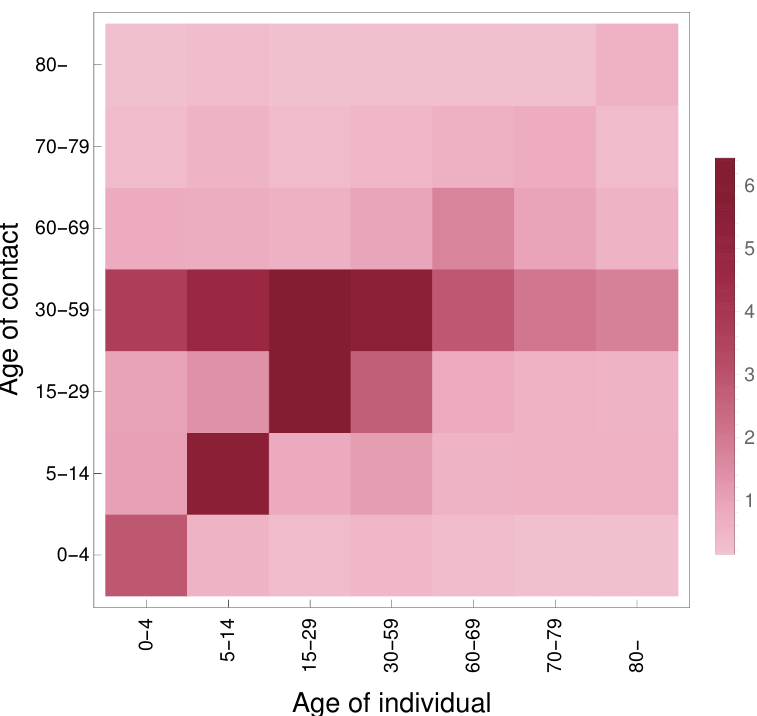
Figure 2. Heatmap of the contact matrix M cont . The image is rotated w.r.t. how M cont is indexed: the ( 1,1 ) element is in the bottom-left